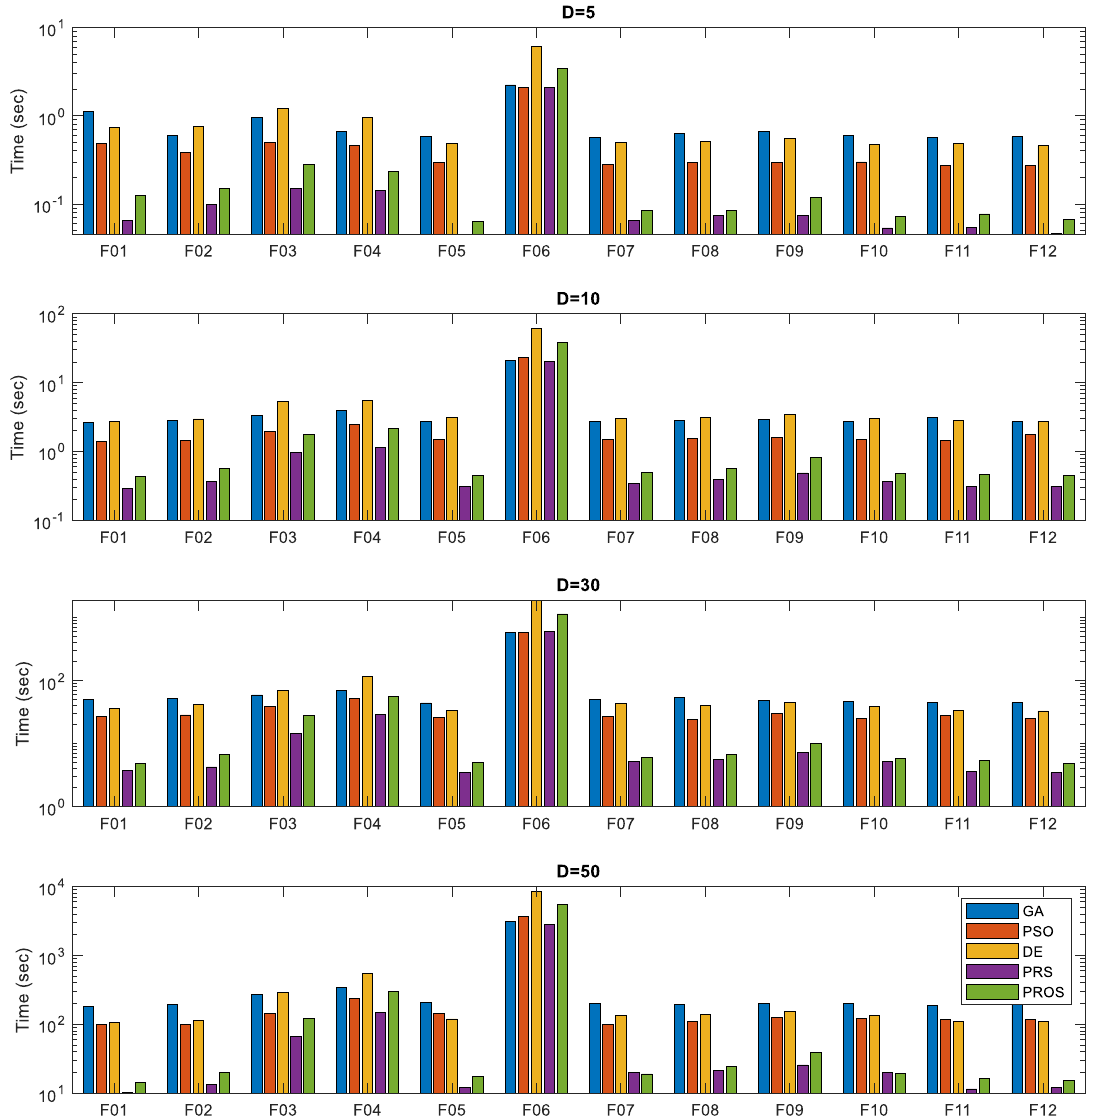
Figure 9. Time needed for the various optimizers, for all 12 objective functions and D = 5, 10, 30, and 50. The y-axis is in logarithmic scale.